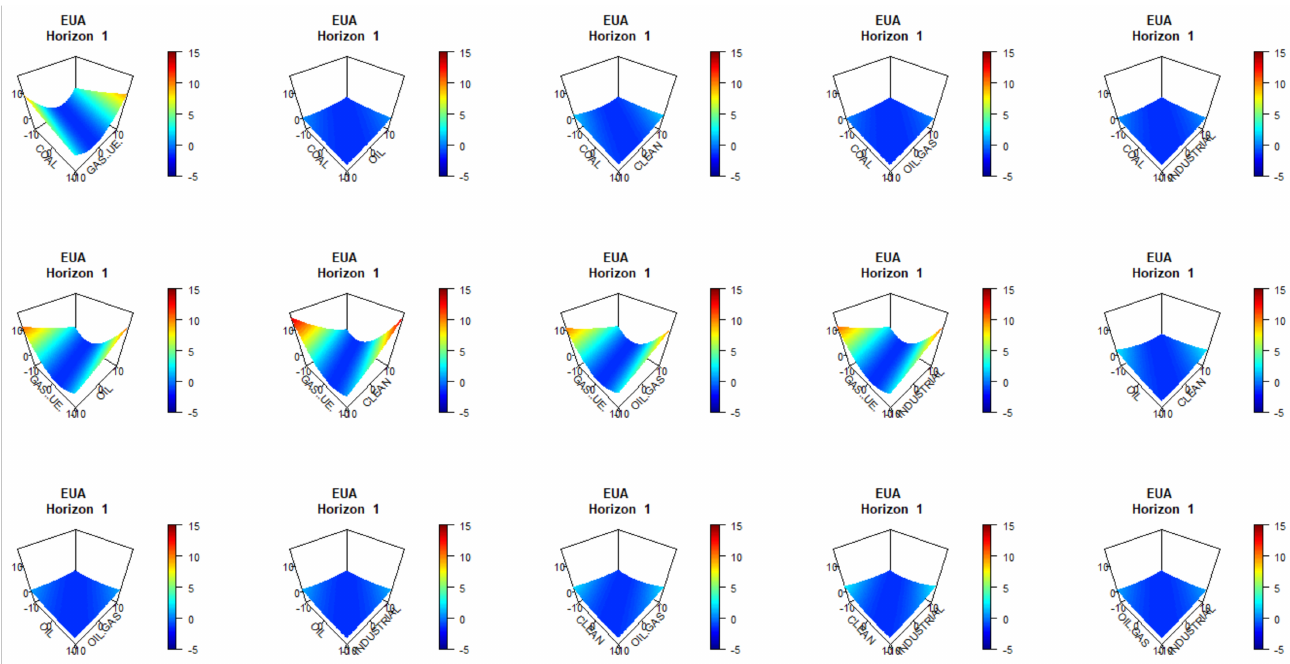
Figure 12. Matrix graph with the response surfaces of the conditional volatility of EUA to bivariate impulses in all pairs of combinations of the rest of the